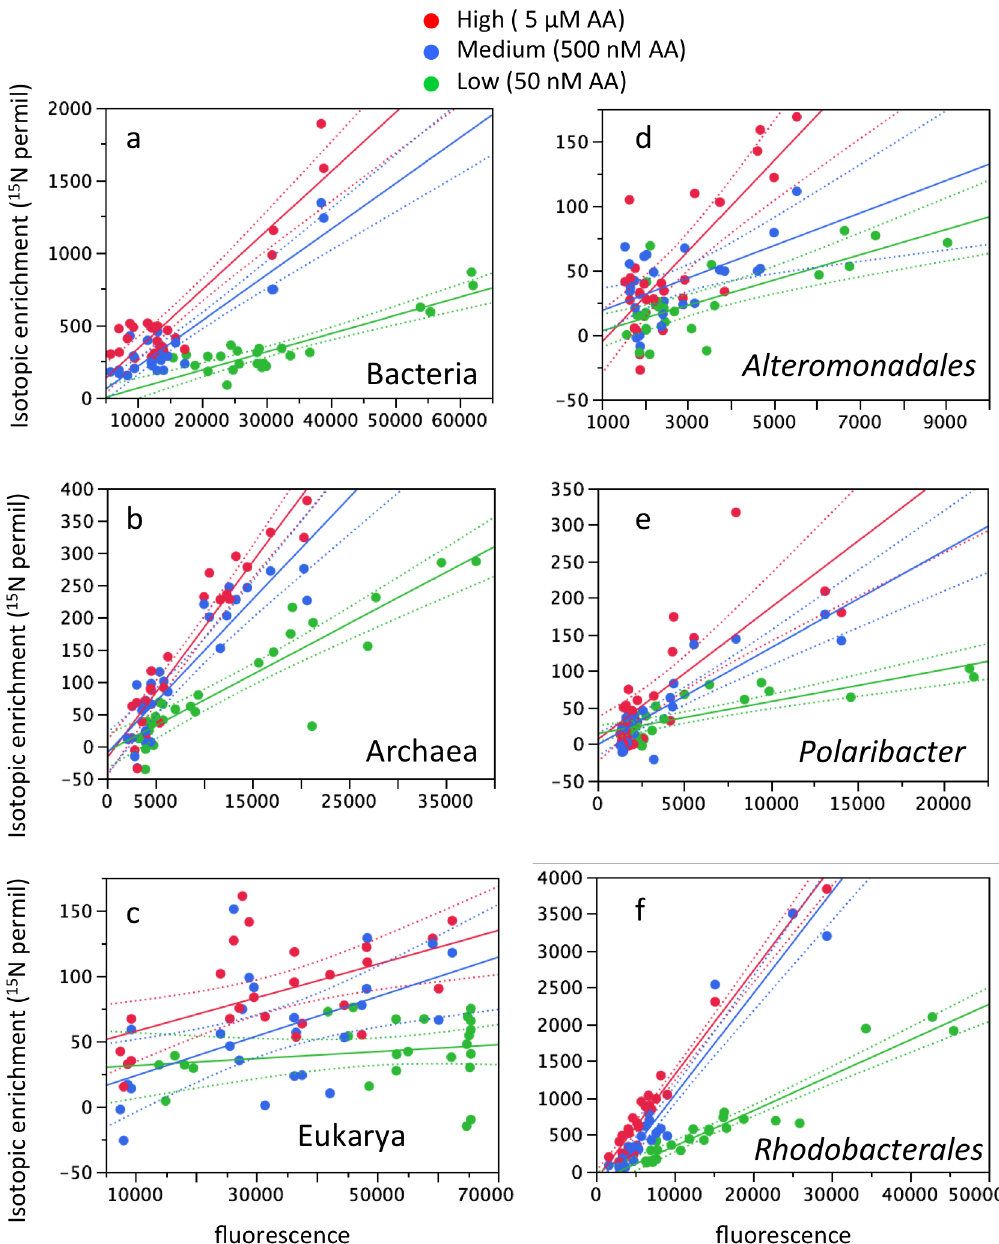
Figure 2. Response of taxa targeted by domain-specific (a–c) and genus or order specific (d–f) probes to increasing amino acid concentrations (red=high, blue=medium, green=low). Data points are for individual probes. Solid lines represent the linear regression and dotted lines are 95% confidence intervals.